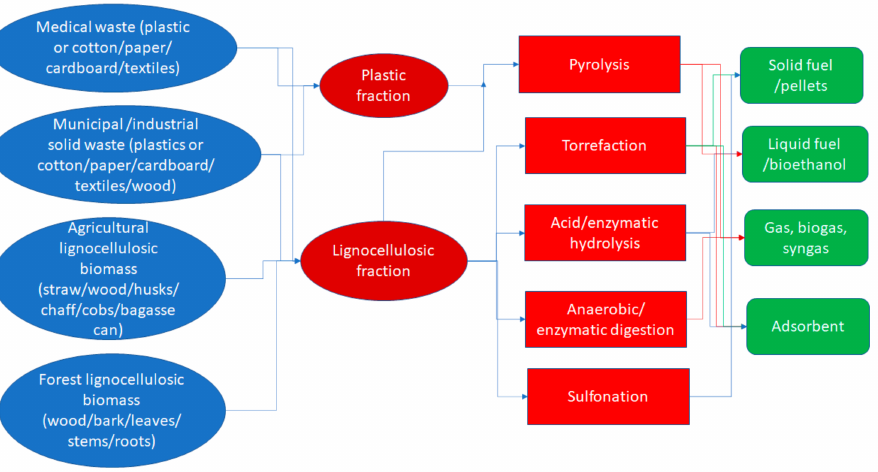
Figure 4. A schematic diagram on co-processing of the plastic/lignocellulosic fraction of medical waste with municipal/industrial solid waste fractions and/or agricultural/forest lignocellulosic biomass for